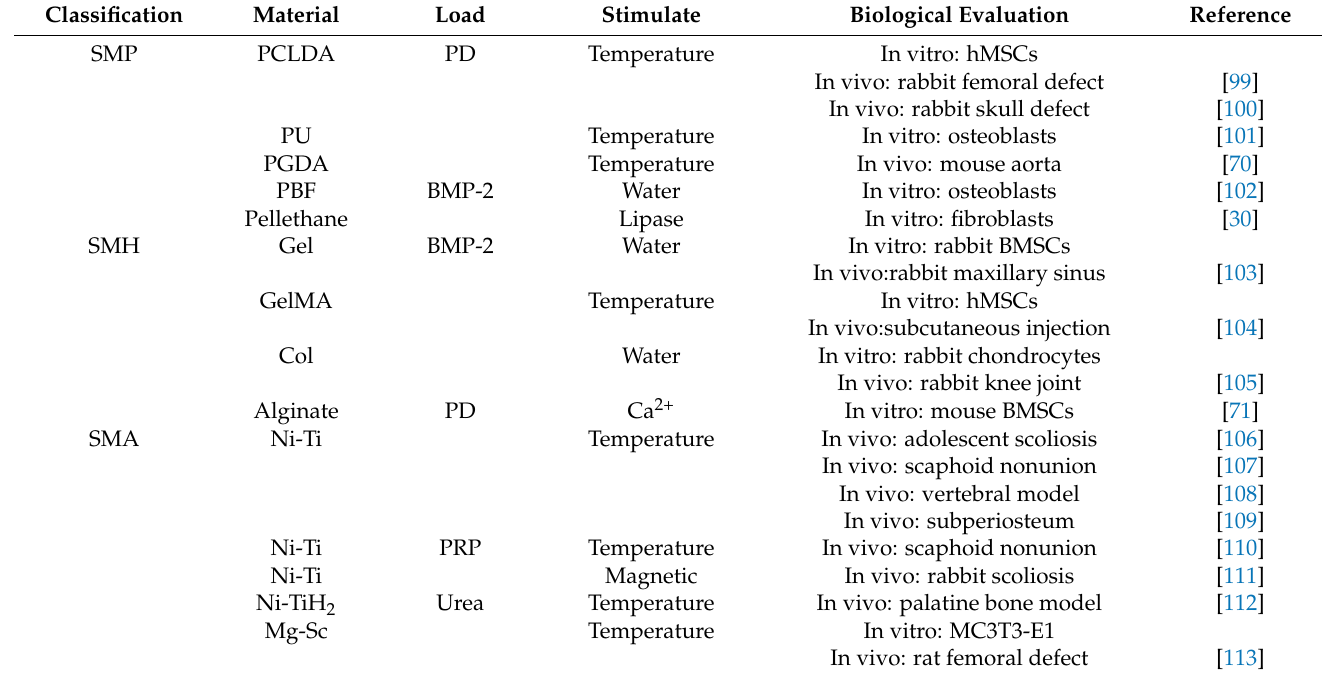
Table 2. Different classification of shape memory materials in bone tissue